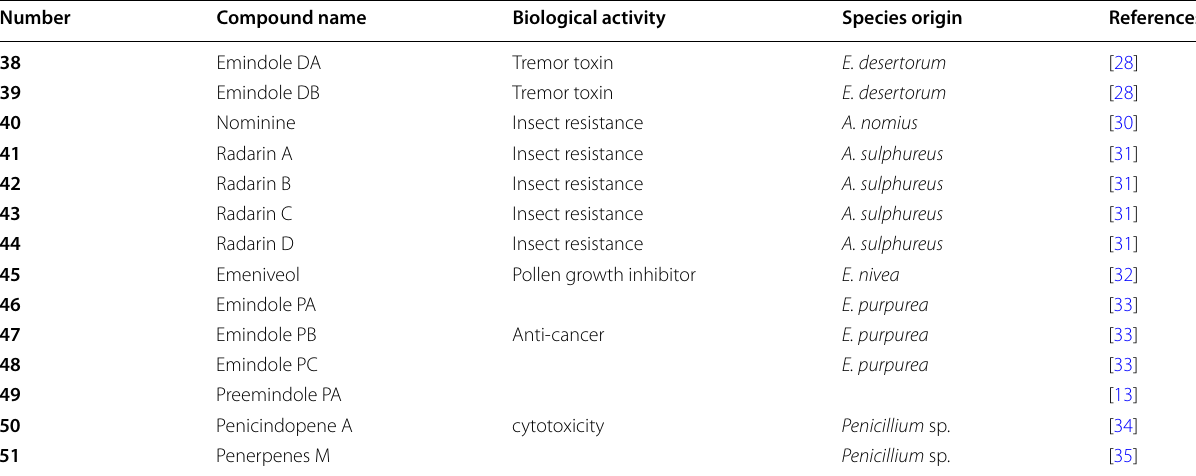
Table 3 Name, bioactivities and source of emindole DA